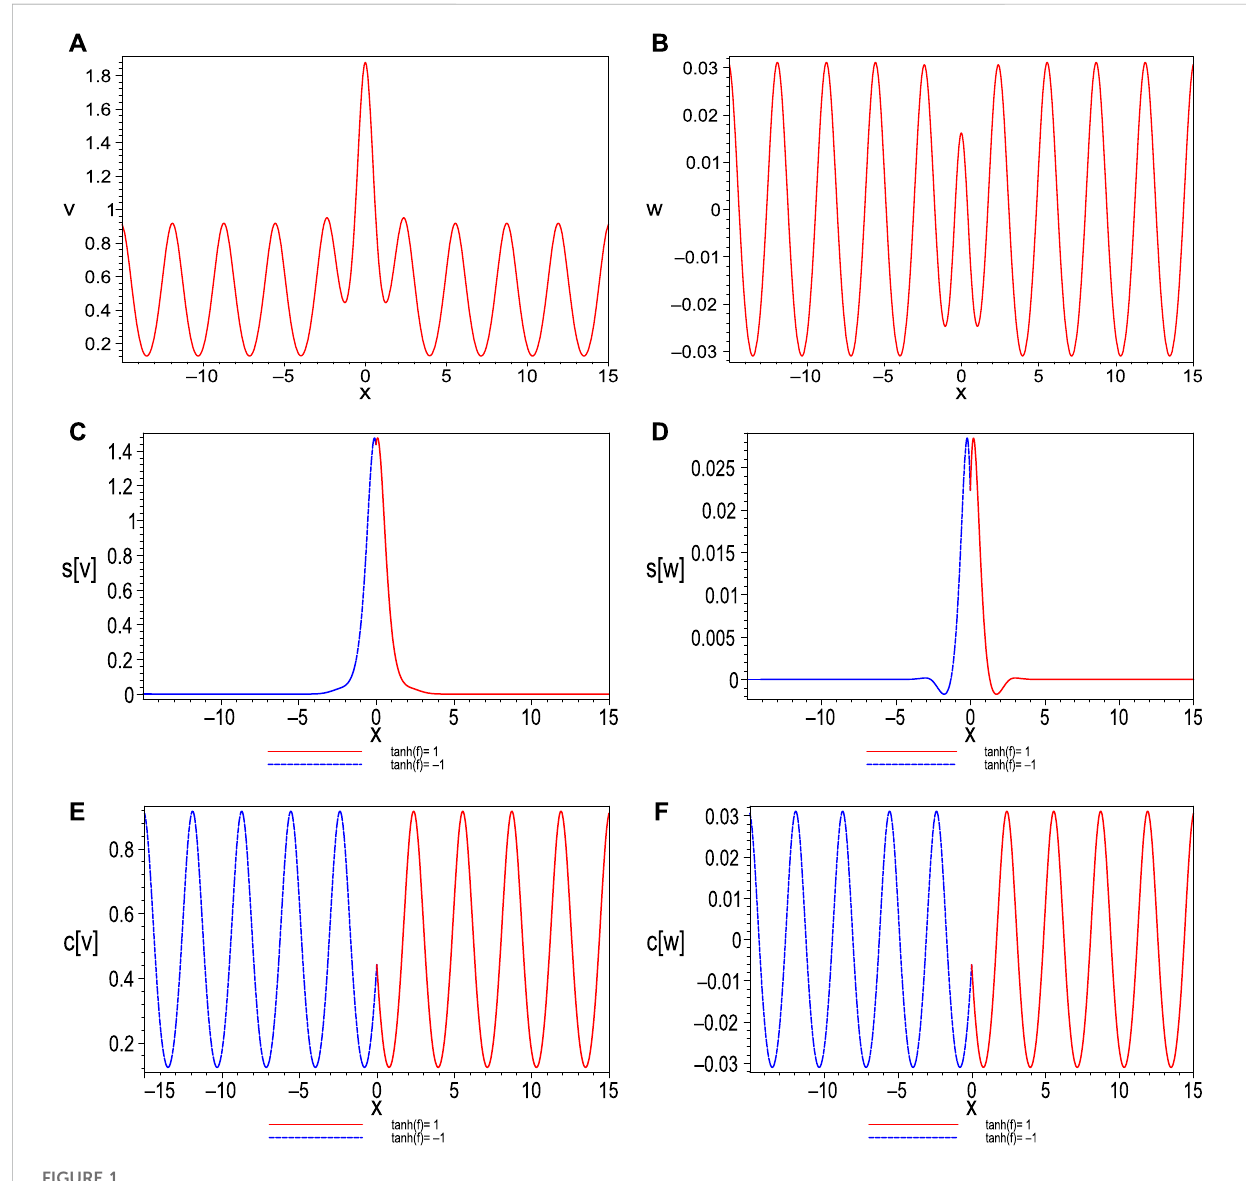
λ = δ = b ω m =0.01. (C) and (D) : 2 =0, 1 =1, 0 =2 and